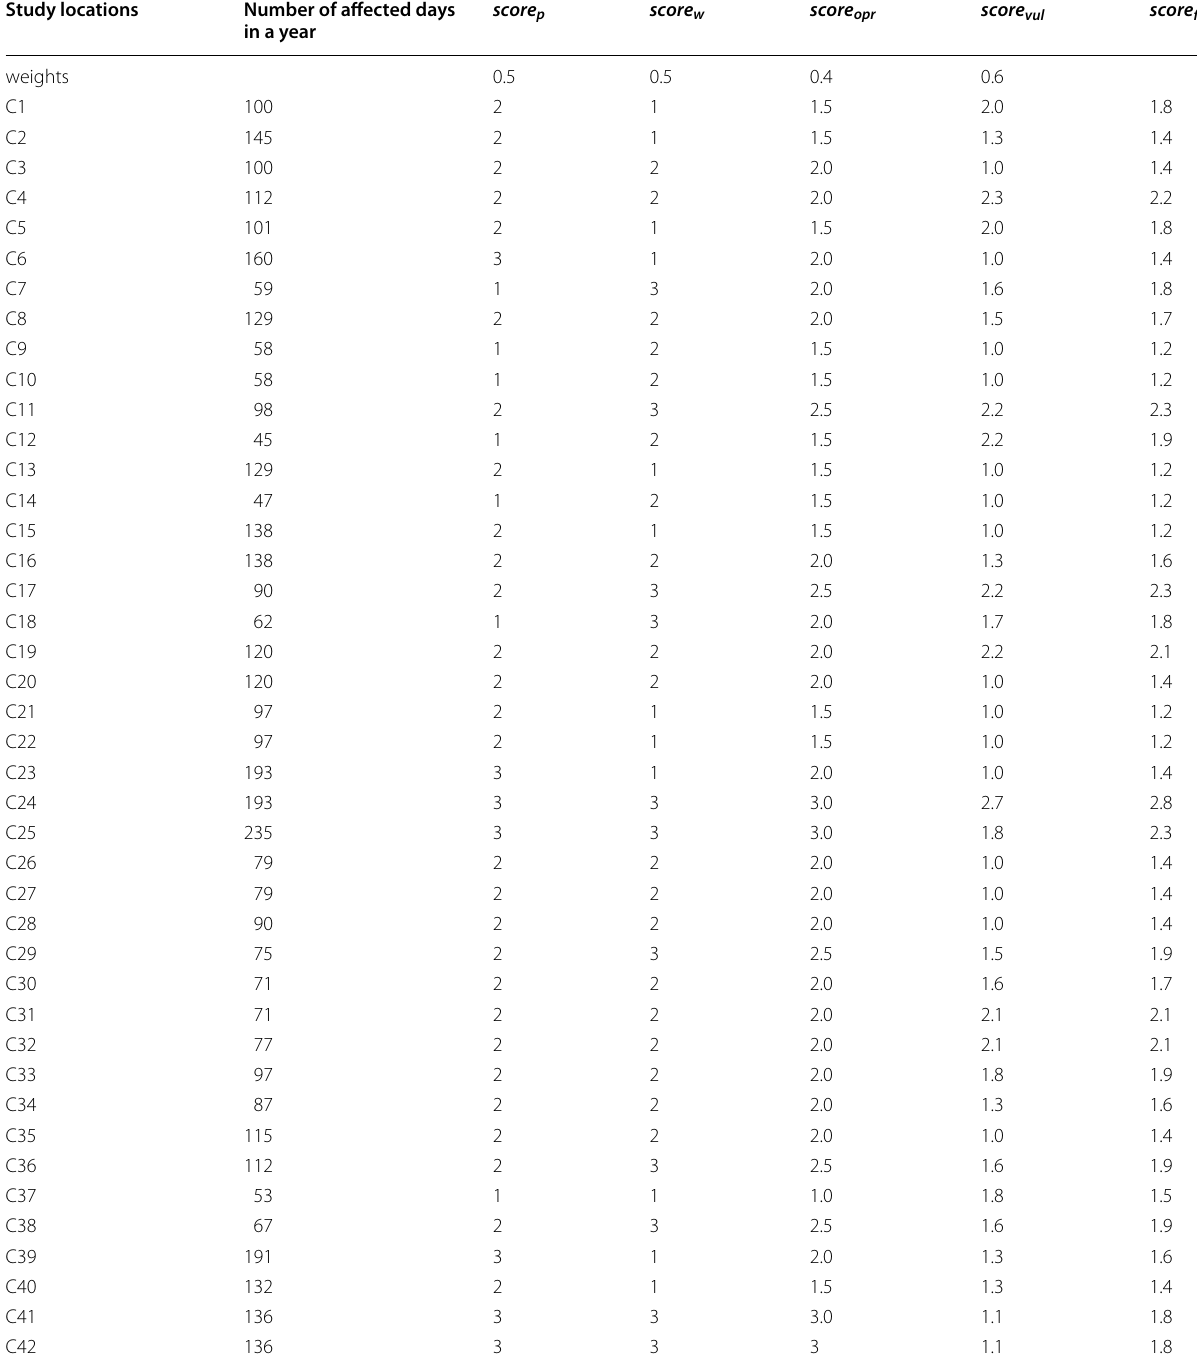
Table 8 Scores from effect of extreme weather events and strong winds for Eq. (3) and the determination of final scores of the study location. The weights used for the calculation of these scores are also shown Study